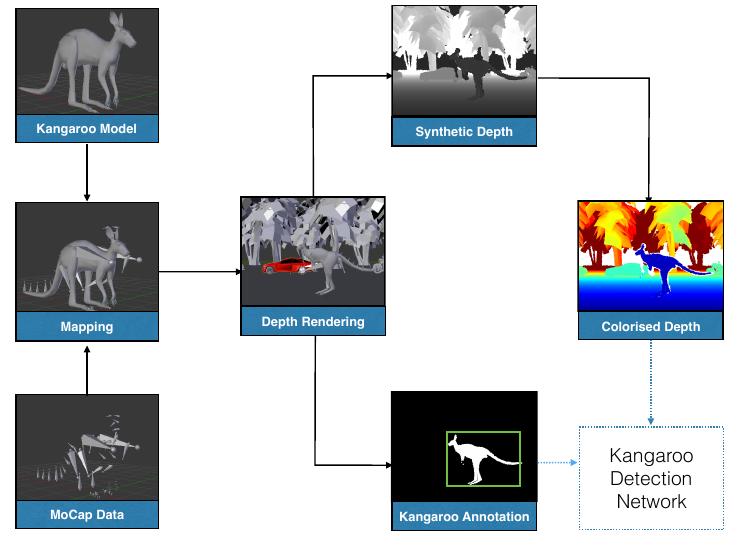
Figure 2. Our pipeline for data generation for the kangaroo detection task. Firstly, the mapping of MoCap data on 3D kangaroo model(s) is performed. Highway and urban traffic scenes are then modeled and merged with animated kangaroos for rendering. Colorized and bounding box annotation of kangaroo instances are then generated.